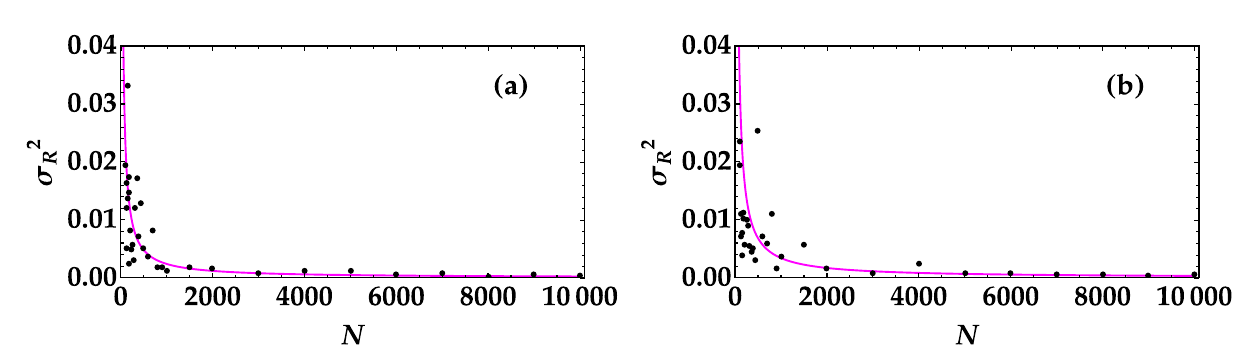
Figure 5. Variance of the noise reduction factor as a function of the number of shots in the case of the higher mean value (left panel) and of the lower mean value (right panel). In each plot the magenta curve is the theoretical fitting function y of randomly distributed